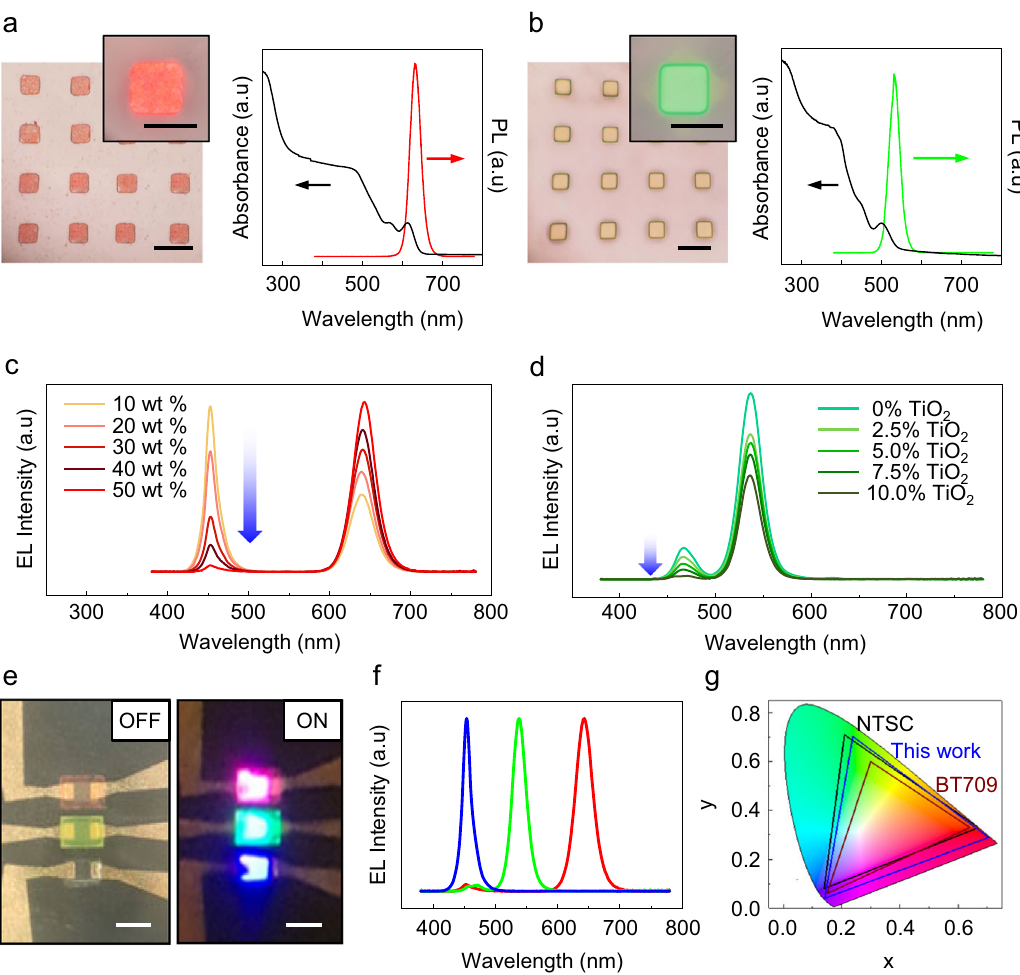
Fig. 2 Photolithographically patternable QD-PR. Optical images of patterned QD-PR, photoluminescence spectra, and UV-Vis absorption spectra of red QD ( a ) and green QD ( b ), respectively. QDs with a size of 50 μ m × 50 μ m are patterned on a glass substrate. Scale bar: 100 μ m. Scale bar: 50 μ m (inset). c Electroluminescence spectra of the micro-LED coated with red QD-PR are measured by varying the concentration of QDs in PR (10, 20, 30, 40, and 50 wt%). d Electroluminescence spectra of the micro-LEDs after mixing TiO 2 into 30 wt% green QD-PR (0, 2.5, 5, 7.5, and 10%). e Optical image showing the off state (left) of the micro-LEDs with patterned QD-PR and on-state (right) after the application of forward voltage. Scale bar: 200 μ m. Electroluminescence spectra ( f ) and CIE chromaticity ( g ) indicating the color properties of the fabricated RGB